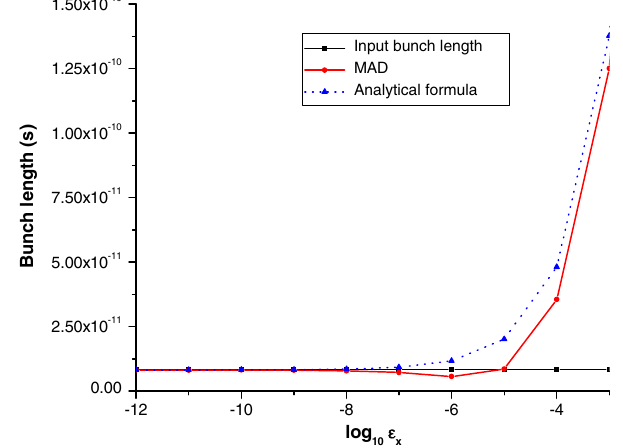
FIG. 4. Variation in bunch length (on momentum particles) with change in horizontal emittance.